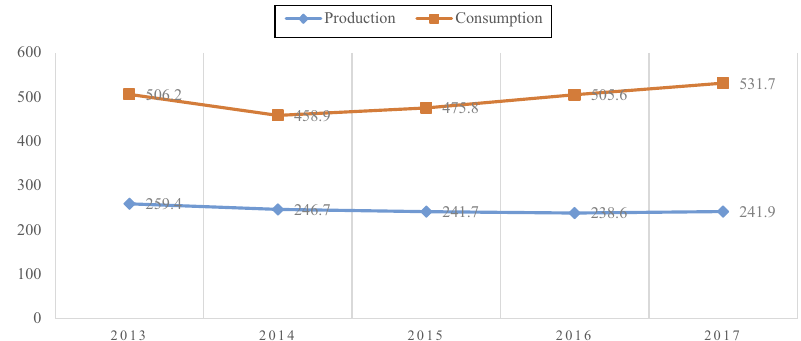
Figure 4. European natural